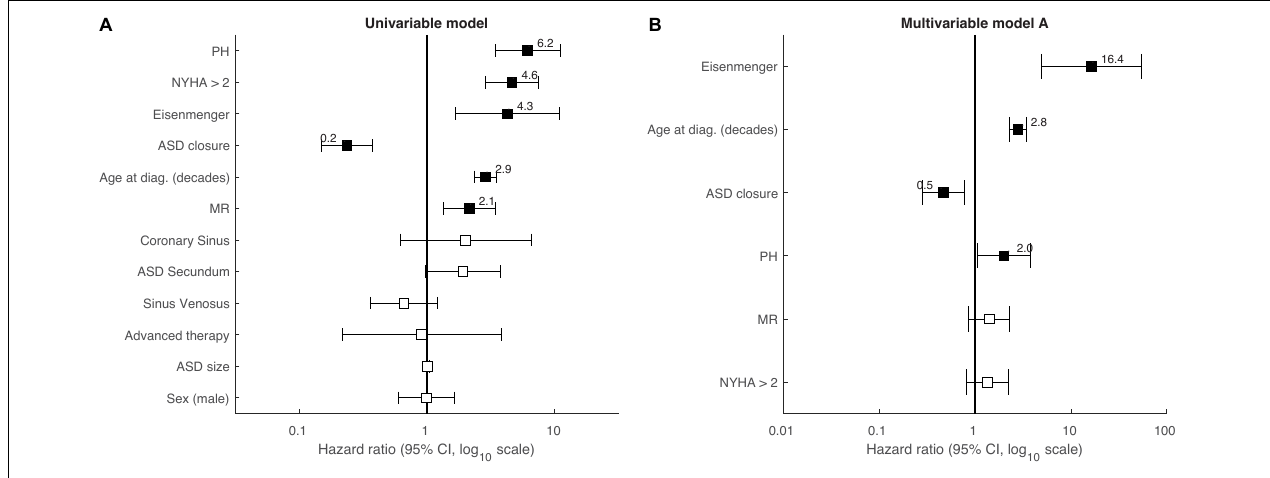
FIGURE 2 | Forest plot of Cox-proportional hazards survival analysis in ASD patients. (A) univariable analysis. (B) Multivariable analysis (all patients, i.e., model A). The forest plot shows the hazard ratios and their 95% confidence intervals at a log 10 scale. Significant variables are highlighted by a filled black square. ASD, atrial septal defect; MR, moderate or severe mitral regurgitation; NYHA, New York Heart Association class; PH, pulmonary